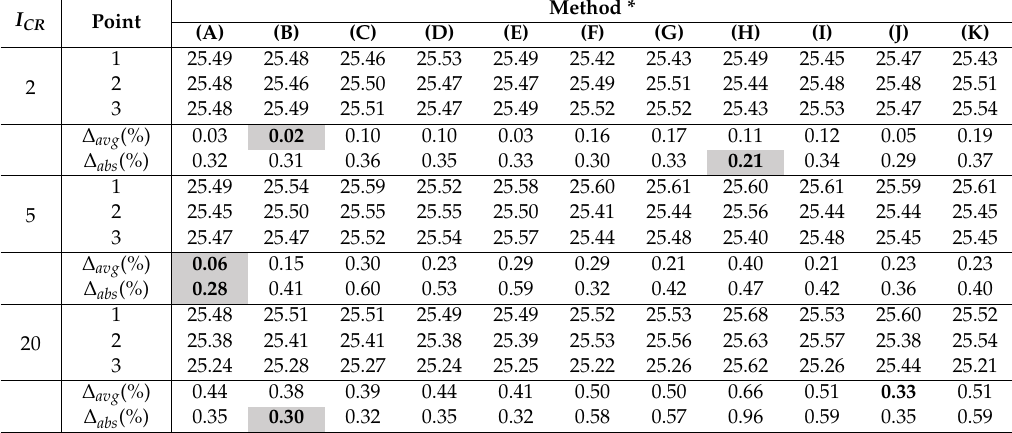
Table 5. Summary of the absolute displacement values (mm) from compressed images along with the average displacement accuracy, ∆ avg ( % ) , with respect to results from uncompressed images and absolute displacement accuracy, ∆ abs (%), with respect to the one inch (25.4 mm) block